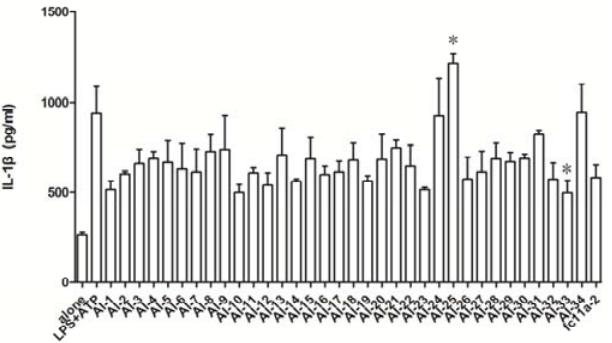
Figure 5. The effects of AI series compounds (10 µ M) on IL-1 β productions in THP-1 cells activated by LPS plus ATP. (The marked compound AI-25 exhibits the best activating activity towards IL-1 β production, while compound AI-33 exhibits the best inhibition activity.)